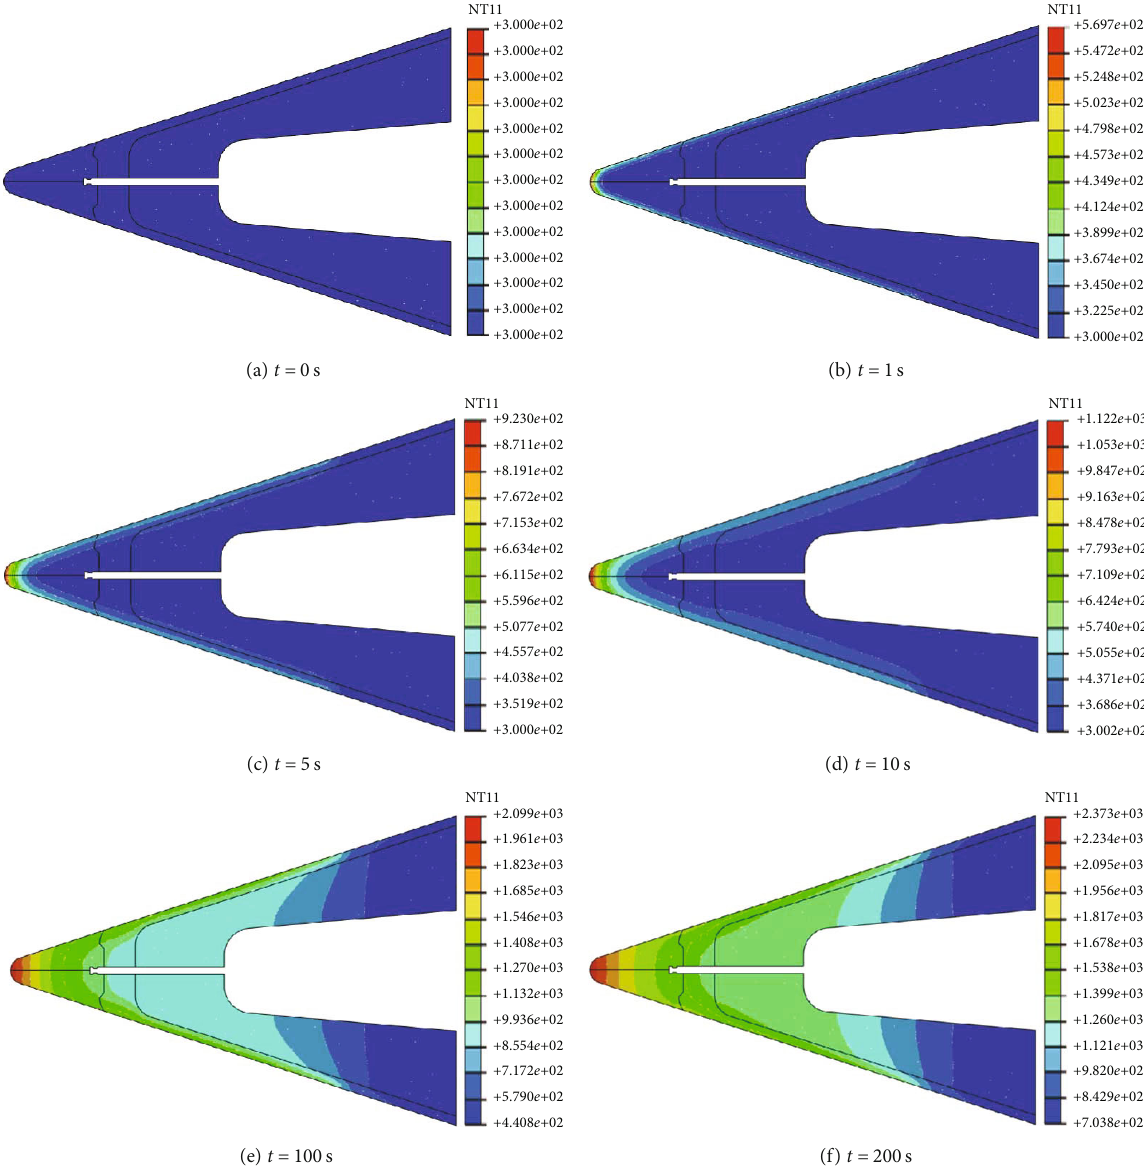
Figure 16: Evolution of temperature distribution of the nose